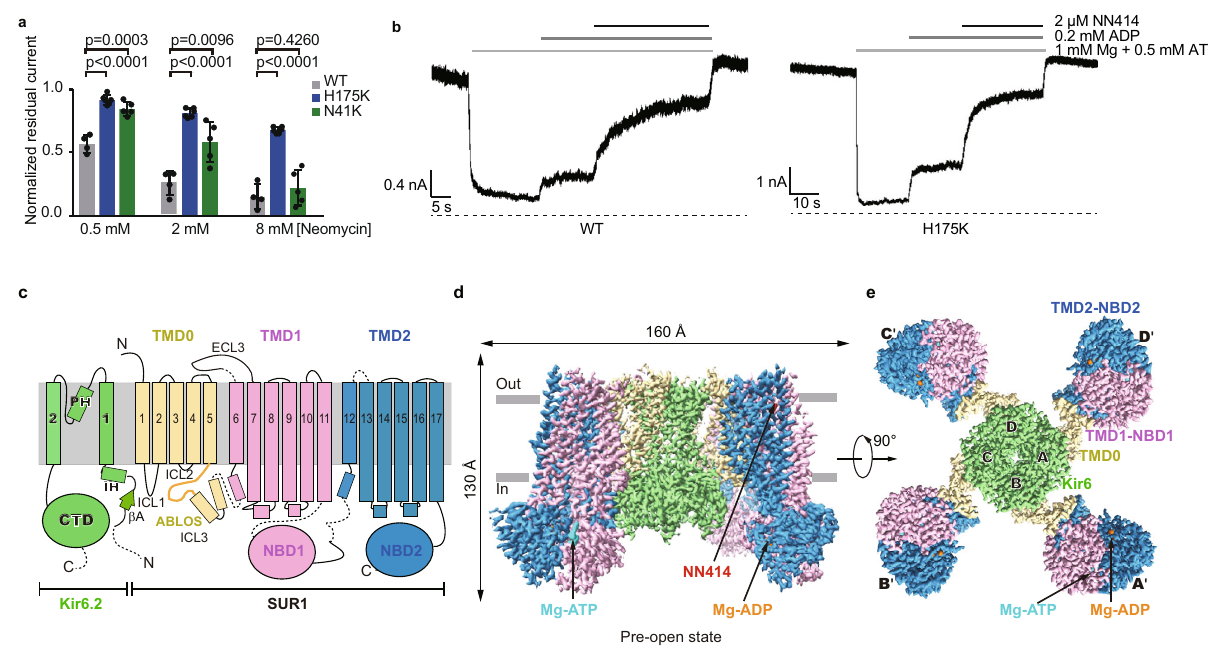
Fig. 1 Structure of the pancreatic K ATP channel (H175K cryo-EM ) in the pre-open state. a Neomycin inhibition of the inside-out currents of the K ATP channel. Wild type (WT), H175K, and N41K mutants of Kir6.2 were co-expressed with wild type SUR1 for recordings. Data are shown as mean ± SD. WT n = 4, H175K n = 6, N41K n = 5 independent patches, respectively. p values were calculated by unpaired two-tailed t -test and were indicated above. b Representative inside-out recordings of K ATP channel formed by the wild-type Kir6.2 or the H175K mutant. c Topology of Kir6.2 and SUR1 subunits. PH, pore helix; ECL, extracellular loop; ICL, intracellular loop; IH, interfacial helix; CTD, cytoplasmic domain; TMD, transmembrane domain; NBD, nucleotide- binding domain. Transmembrane helices are shown as cylinders. The phospholipid bilayer is shown as thick gray lines. Kir6.2, SUR1 TMD0-ICL3 fragment, TMD1-NBD1, and TMD2-NBD2 are shown in green, yellow, violet, and blue, respectively. d Side view of the K ATP complex in the pre-open state. Mg-ADP, Mg-ATP, and NN414 are shown in orange, cyan, and red, respectively. e Bottom view of the K ATP channel in the pre-open state from the intracellular side. Source data are provided as a Source Data fi